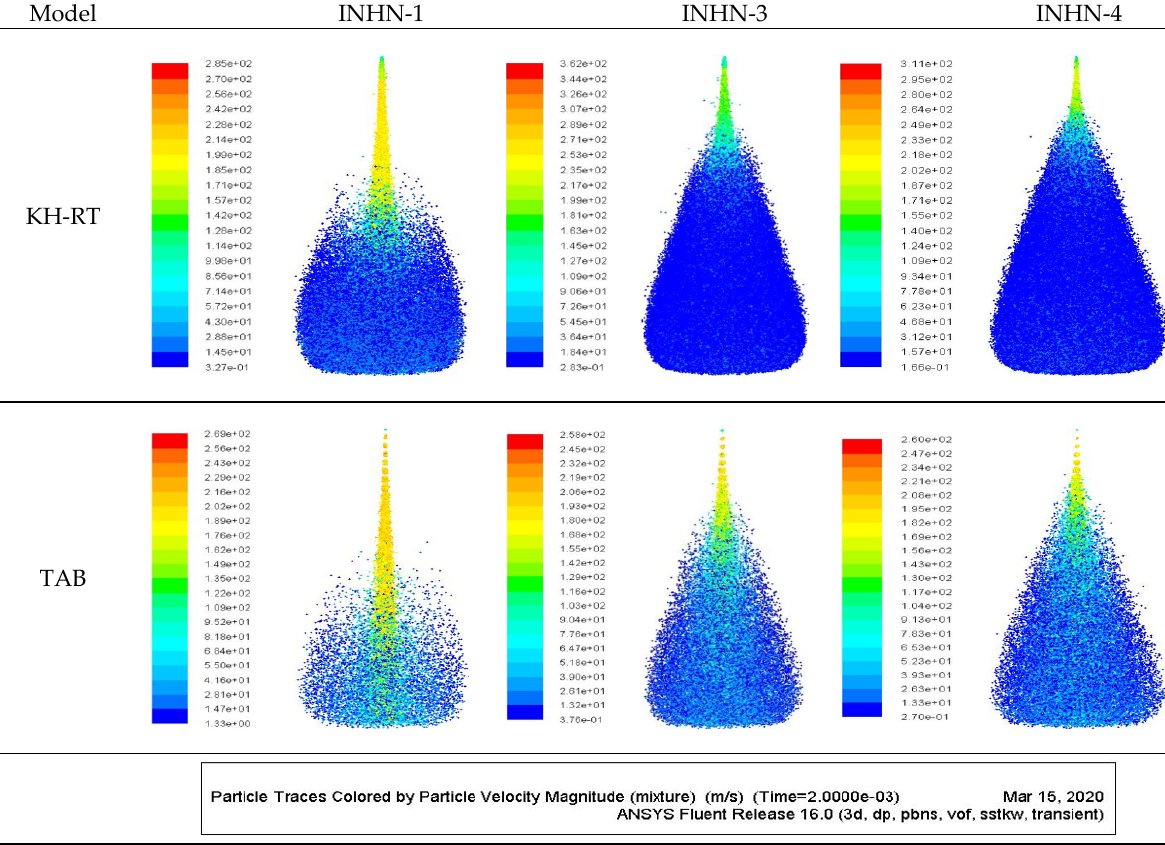
Figure 12. Particle velocity magnitude for different injector nozzles. (d) Influence of INNHs and orifice size on the particles mean diameter The ratio of the drop volume to its surface area is the particle mean diameter [19,20]. By gradually reducing the droplet size difference while increasing INHNs and decreas- ing the particle mean diameter, consistent particle size distribution was achieved (Figure 13). Further experimental tests of the various injector nozzles based on varied injection pressures are required, as mentioned in all of the simulation work findings.